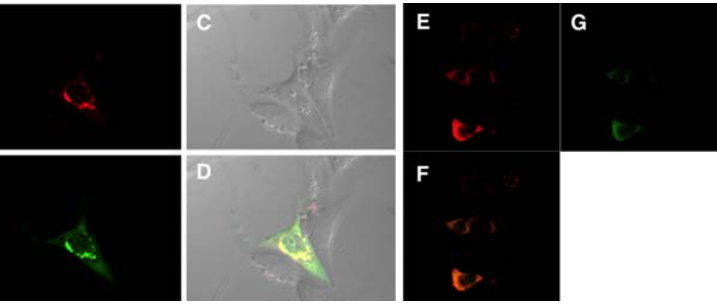
Figure 6. Localization of APOBEC3 and DND1 in NIH3T3 and 293T cells. (a–d) Co-transfection of mCherry-Apobec3 and GFP-DND1 expression constructs into NIH3T3 cells. Cells were fixed with 2% paraformaldehyde before visualization of fluorescent signal by confocal microscopy. (a) Red fluorescence due to mCherry-APOBEC3 was imaged using red filter (excitation at 548 nm); (b) green fluorescence due to GFP-DND1 was imaged using green filter (excitation at 488 nm); (d) merged image of red and green filters showing APOBEC3 and DND1 co-localize (yellow signal) near perinuclear region in NIH3T3 cells. (c) The DIC (differential interference contrast) image of the cells. (e–g) Co-transfection of mCherry-Apobec3 and GFP-DND1 expression constructs into 293T cells. Cells were fixed with 2% paraformaldehyde before visualization of fluorescent signal by confocal microscopy. (e) Image of red fluorescence due to mCherry-APOBEC3 (red filter; excitation at 548 nm); (g) green fluorescence due to GFP-DND1 (green filter, excitation at 488 nm) and (f) merged image of red and green filters showing APOBEC3 and DND1 co-localize to cytoplasm in 293T